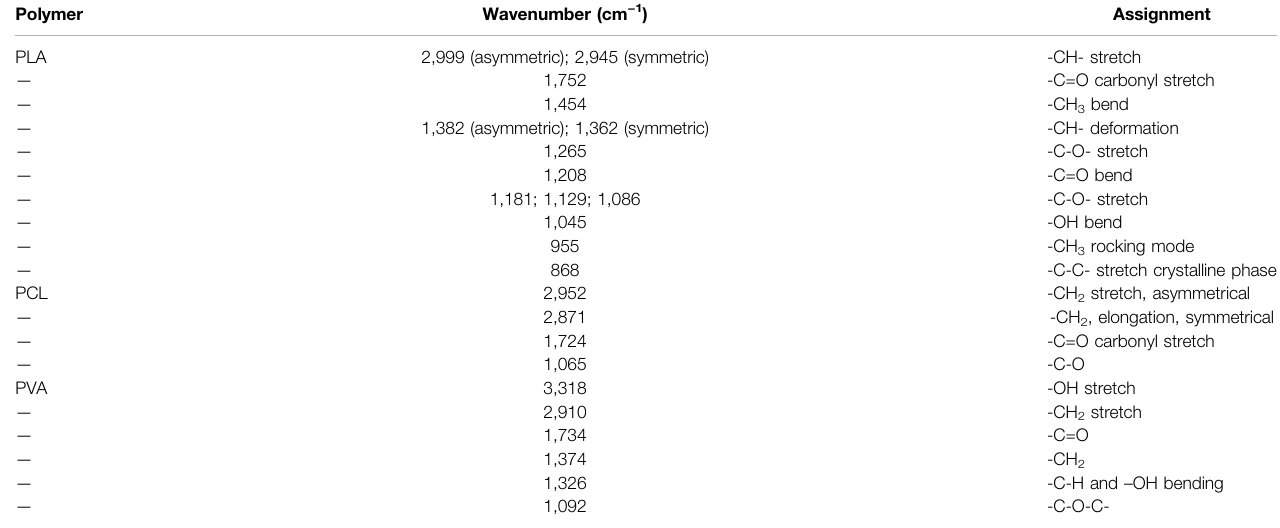
TABLE 2 | Main infrared bands in the FTIR (ATR) in the region from 4,000 cm − 1 to 700 cm − 1 .